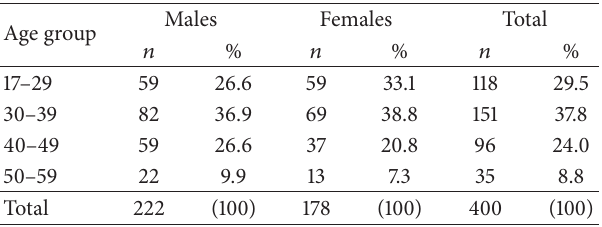
Table 1: Distribution of the study participants by age groups and